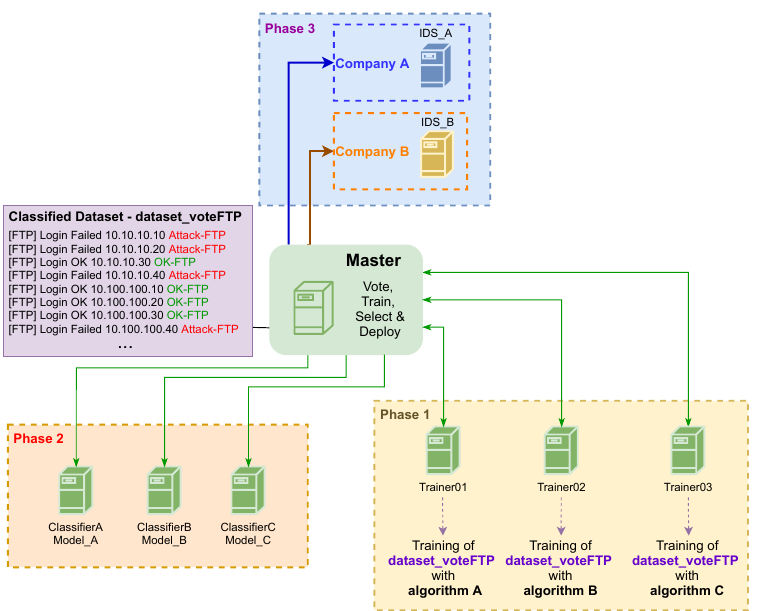
Figure 7. New training, selection and deployment.